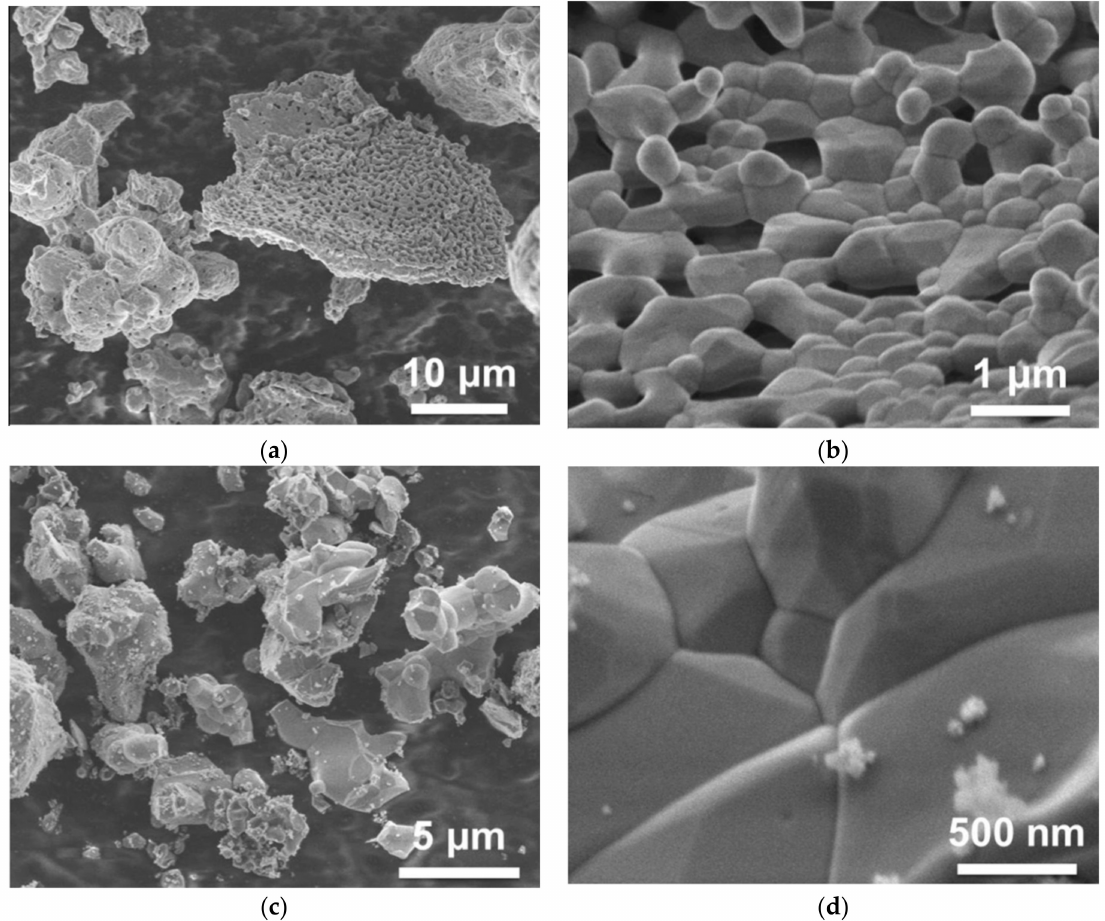
Figure 1. SEM images of co-precipitated Gd 3 Ga 3 Al 2 O 12 :Ce powder after thermal treatment at 1200 ◦ C ( a , b ), and powder obtained by solid state synthesis at 1400 ◦ C ( c , d